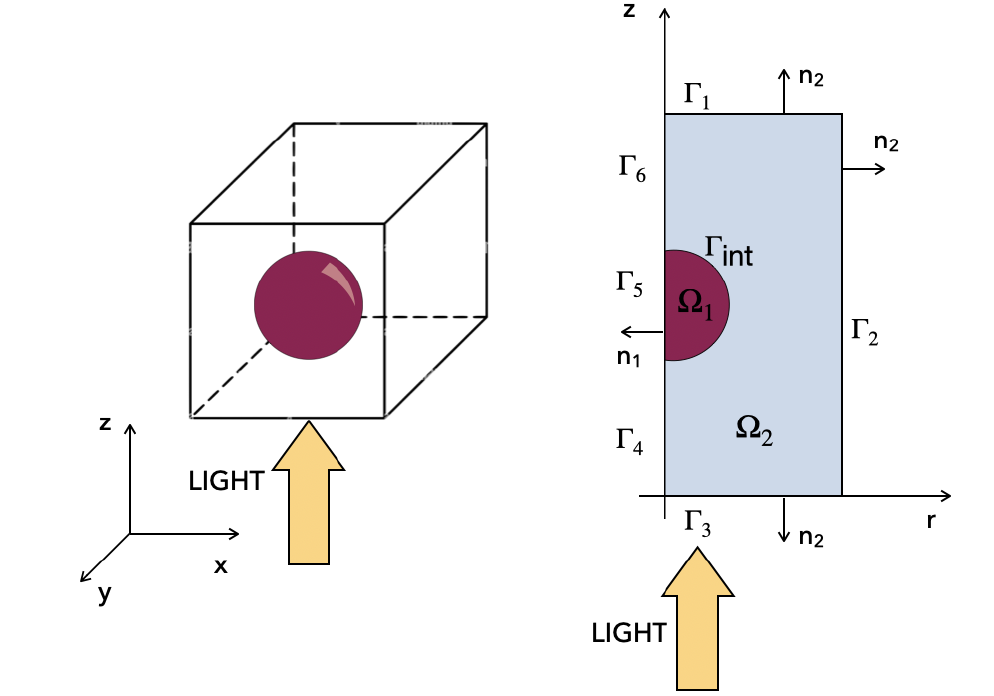
Figure 1. ( Left ) panel: three-dimensional representation of the bio-hybrid system. ( Right ) panel: two-dimensional axial symmetric computational domain. The NP region is denoted by Ω 1 . The sur- rounding region is denoted by Ω 2